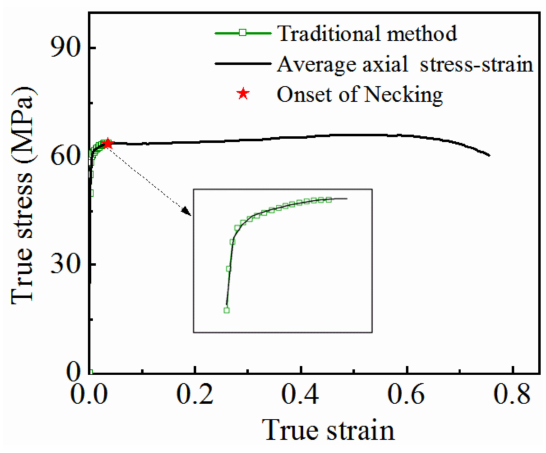
Figure 10. Axial average true stress–strain curve based on strain measurement technology.